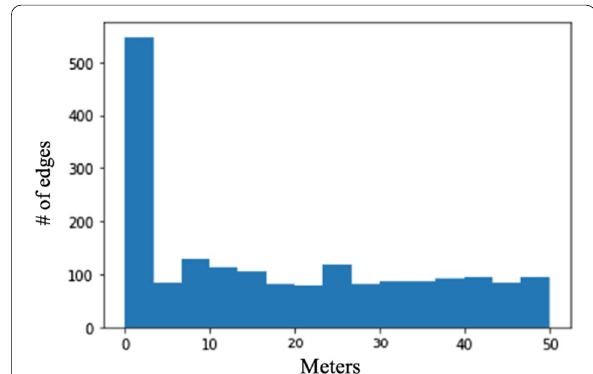
Fig. 4 The distribution of distances associated with the 1878 intermodal connections has a very high cardinality of distances close to 0 m. This represents the stations/stops that simultaneously link layers